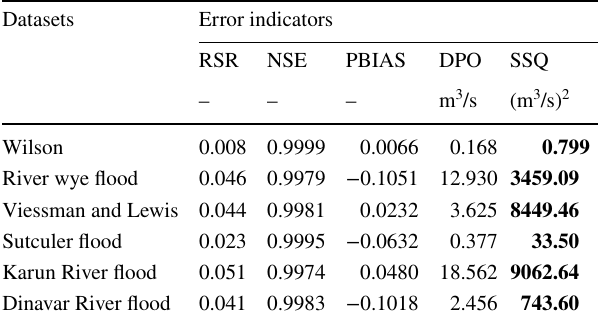
Table 8 Error indices for evaluating NL5-AL model in examples 1